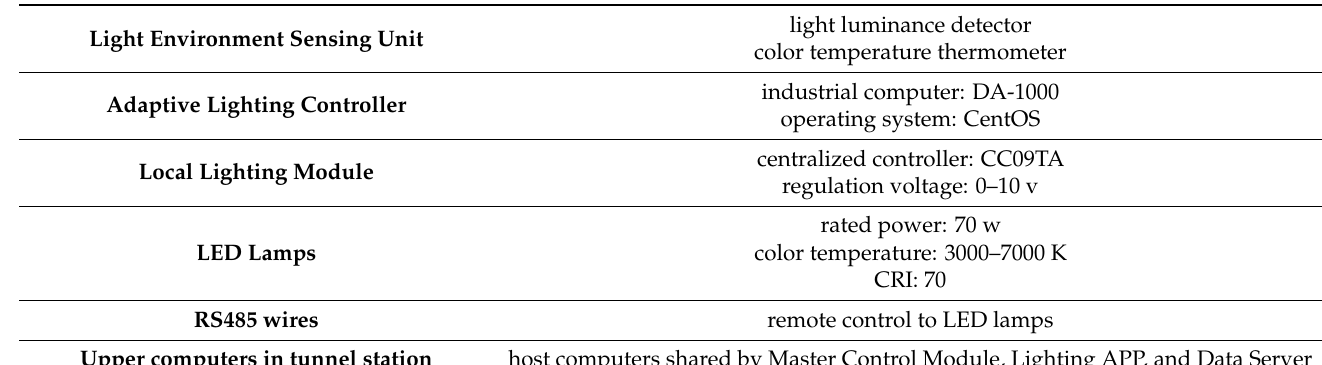
Table 10. Main functional components and hardware